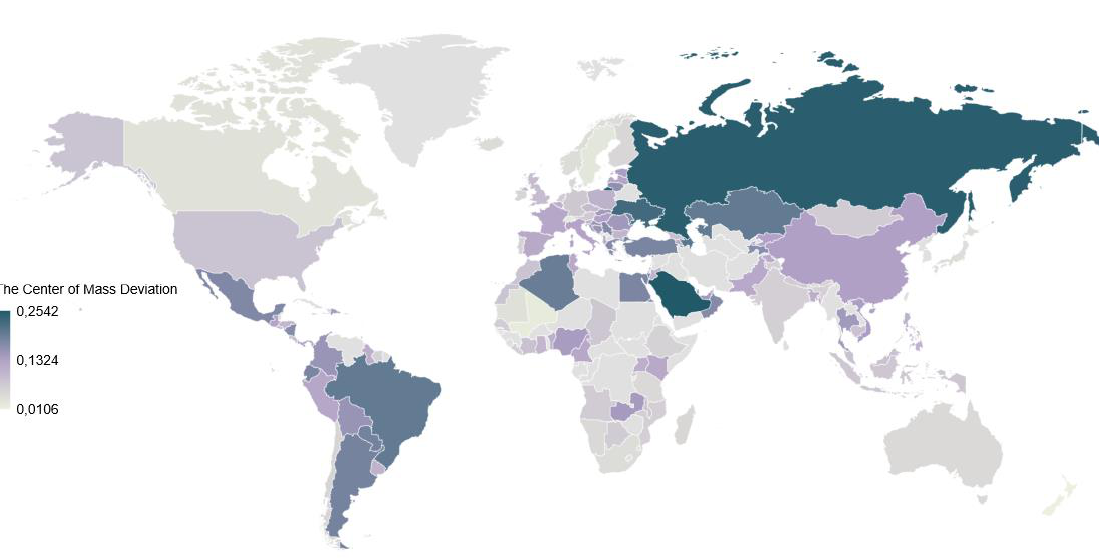
Figure 10. The level of countries’ development balance is based on the deviation of the centers of mass in their barycentric models. Source: Authors’